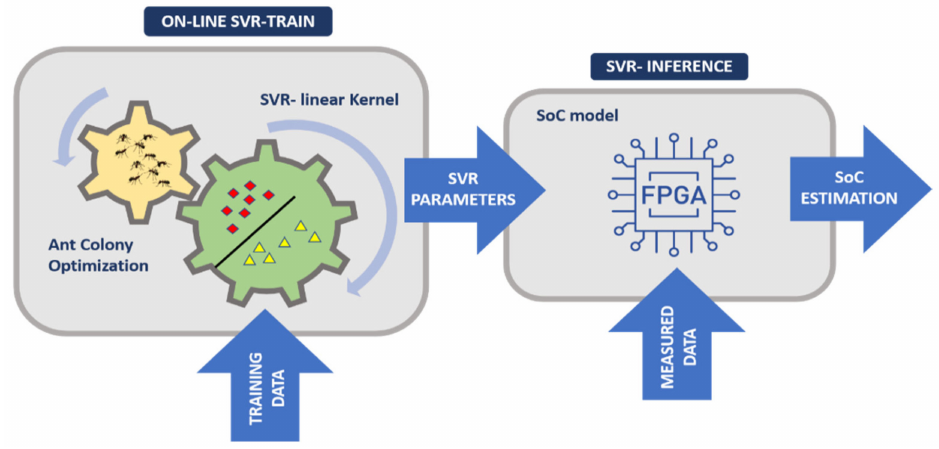
Figure 1. System architecture overview.